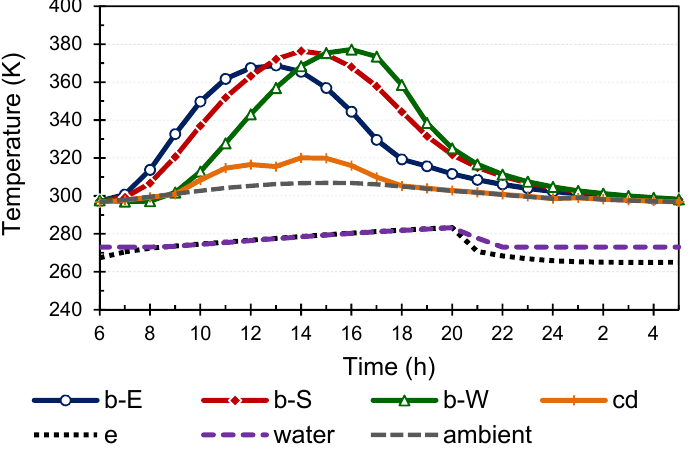
Figure 8. Temperatures of main heat exchangers of the system (28 August 2005, = L =1.25 m, L = 0.5 L cpc,E cpc,W cpc,S